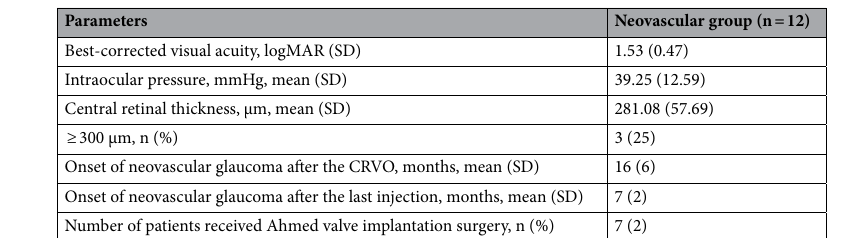
Table 2. Clinical characteristics of neovascular glaucoma patients at the time of diagnosis and clinical prognosis of neovascular glaucoma patients. CRVO central retinal vein occlusion.